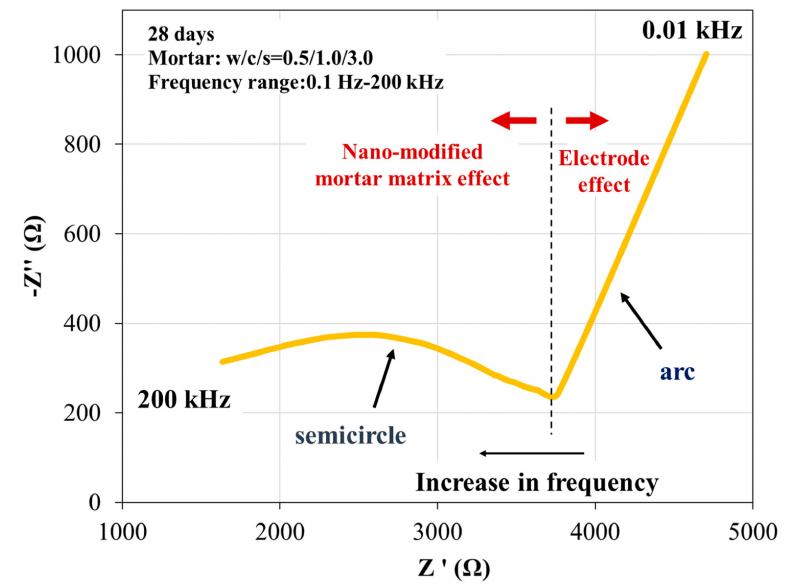
Figure 8. A typical Nyquist plot of a 28-day nano-reinforced cement mortar matrix with 0.3% carbon nanotubes